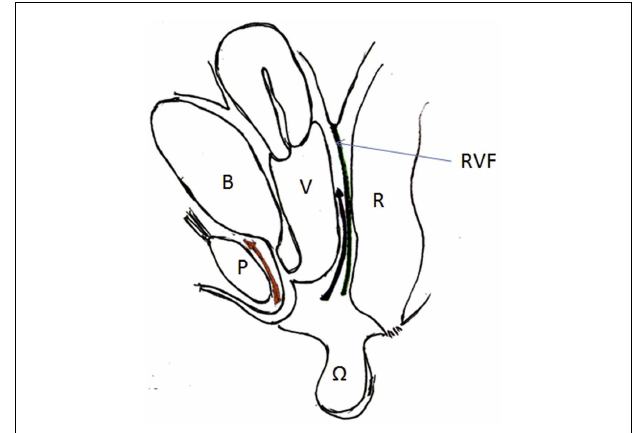
FIGURE 2 |Artist’s representation of the anatomy and planes of dissection . B, bladder; U, urethra;V, vagina; P, pubis; RVF, rectovaginal fascia. Anteriorly the dissection should be close to the pubis, posteriorly close to the vagina, and laterally a few millimeters away from the vaginal wall.